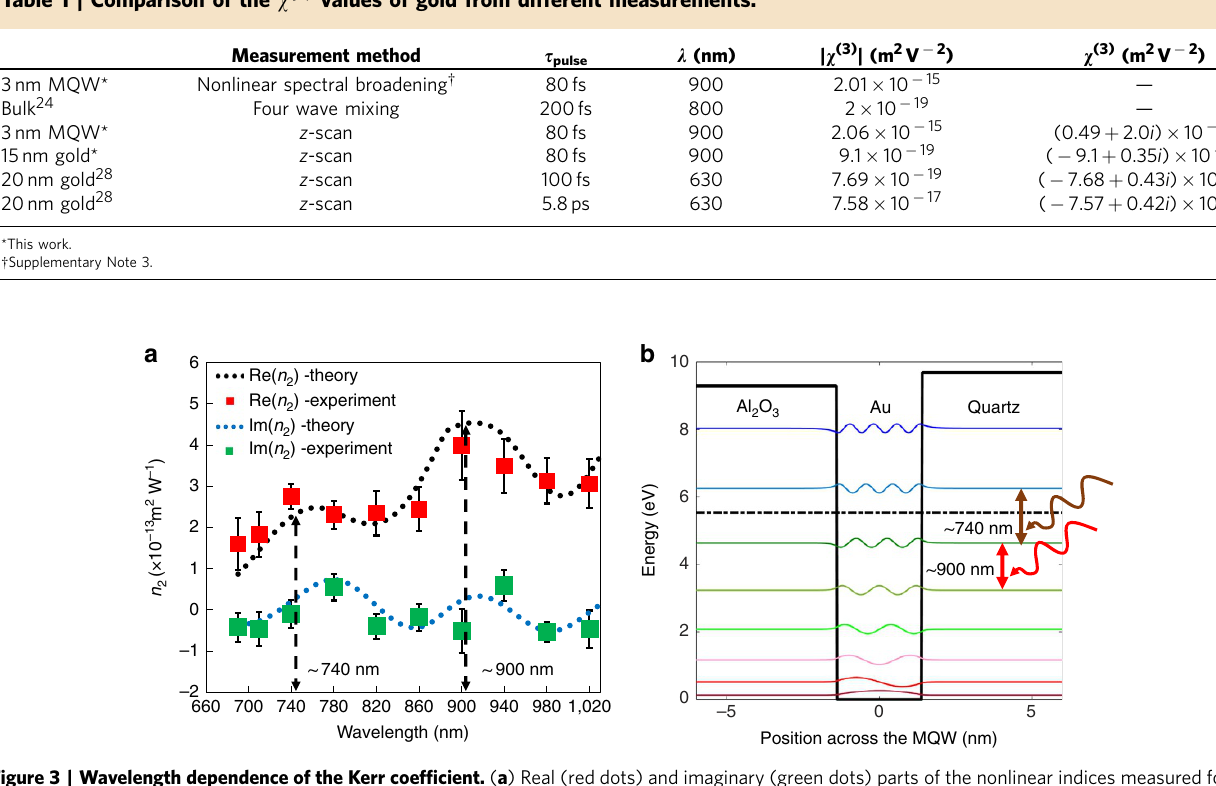
Figure 3 | Wavelength dependence of the Kerr coefficient. ( a ) Real (red dots) and imaginary (green dots) parts of the nonlinear indices measured for the 3nm MQW as a function of incident laser wavelength. The fluctuations in multiple measurements at various locations are indicated by the error bars (s.d.). Two resonance peaks are found near 740 and 900nm, respectively. Theoretical predictions (black and blue dotted lines) agree well with experimental results. ( b ) Calculated quantized energy states and their corresponding wave functions from the self-consistent calculation of the Schro¨dinger and Poisson’s equations. For the 3nm quantum well, the dipole dephasing time, which relates to the damping rate as t ¼ 1/ g , is 7.5fs and the effective mass of the electron is 0.35 (cid:2) m e , where m e is the free electron mass 31 . The Fermi energy level is plotted by dash-dotted black line. The transitions responsible for the two resonances observed in ( a ) are marked as the arrows in this figure as